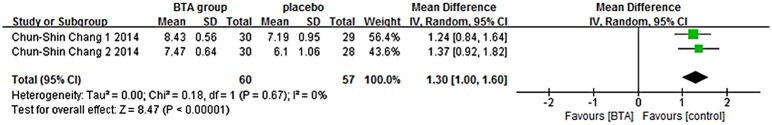
VAS forest plot (BTA vs. Placebo).